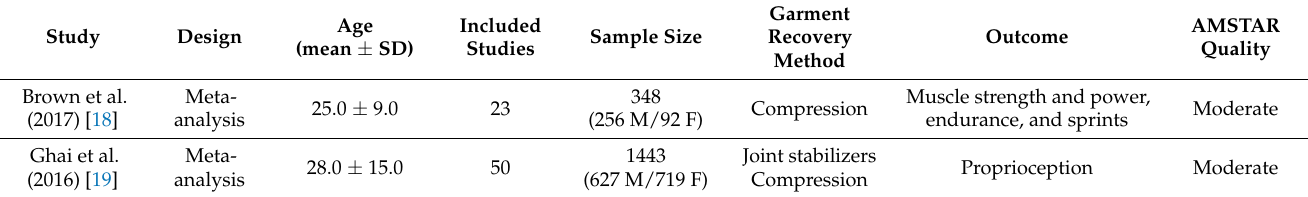
Table 2. General characteristics of the included systematic review and meta-analyses